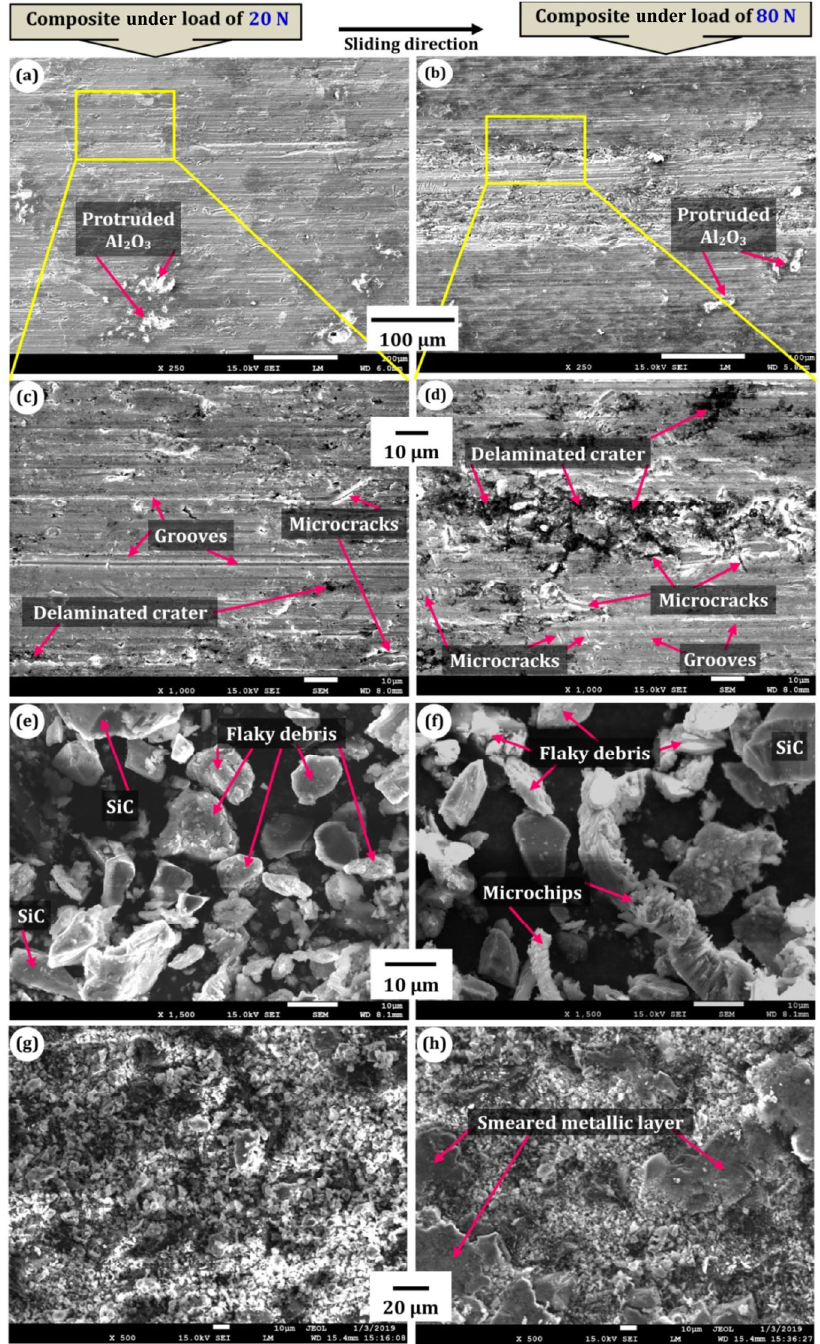
Fig. 6 FE SEM micrographs illustrating the effects of load on the characteristics of abraded surfaces (a − d), generated debris (e–f), and abraded SiC emery papers (g–h) for composite against 23 μ m sized SiC abrasives covering a sliding distance of 20 m with a velocity of 0.5 m·s − 1